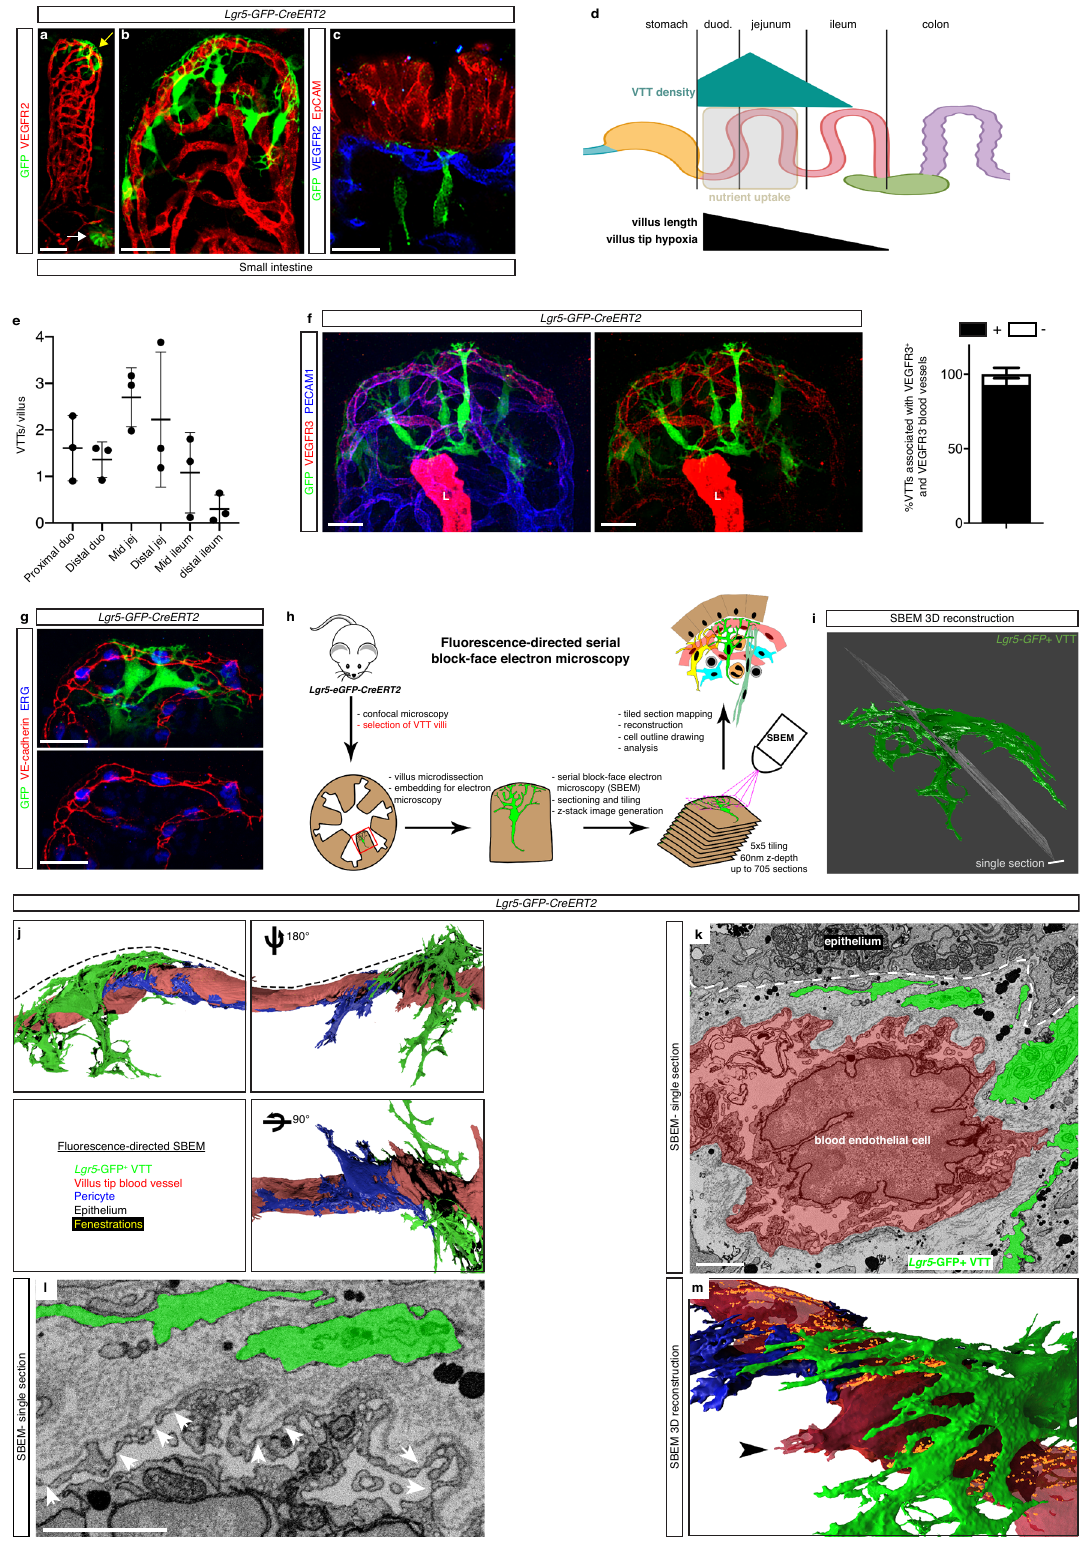
To identify VTTs, we focused on the subepithelial fi broblast cluster, highlighted by expression of Pdgfra , Tnc , and F3 , which contained two subsets, A and B (Fig. 4c; Supplementary Fig. 5c). PDGFR α and F3, also known as tissue factor, are markers of subepithelial cells 41,42,47,48 and immunostaining con fi rmed sub- epithelial expression of F3 and PDGFR α in VTTs (Fig. 4d,